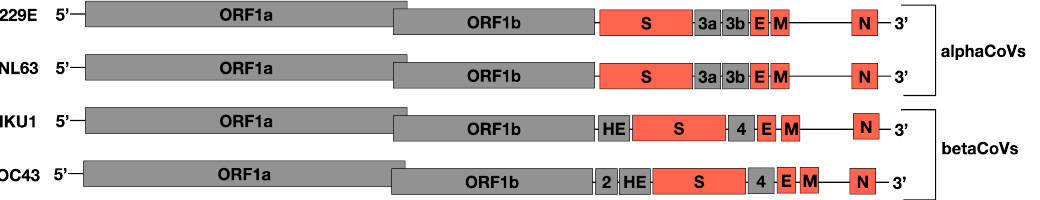
Figure 1. An illustration of the sHCoV genomes, not drawn to scale. The ORFs analyzed in this study are indicated in orange.